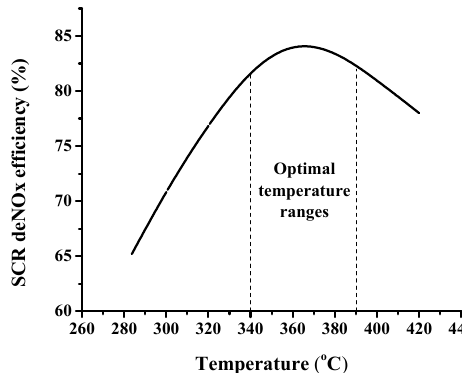
Figure 1. SCR de-NO x efficiency variation with the temperature.